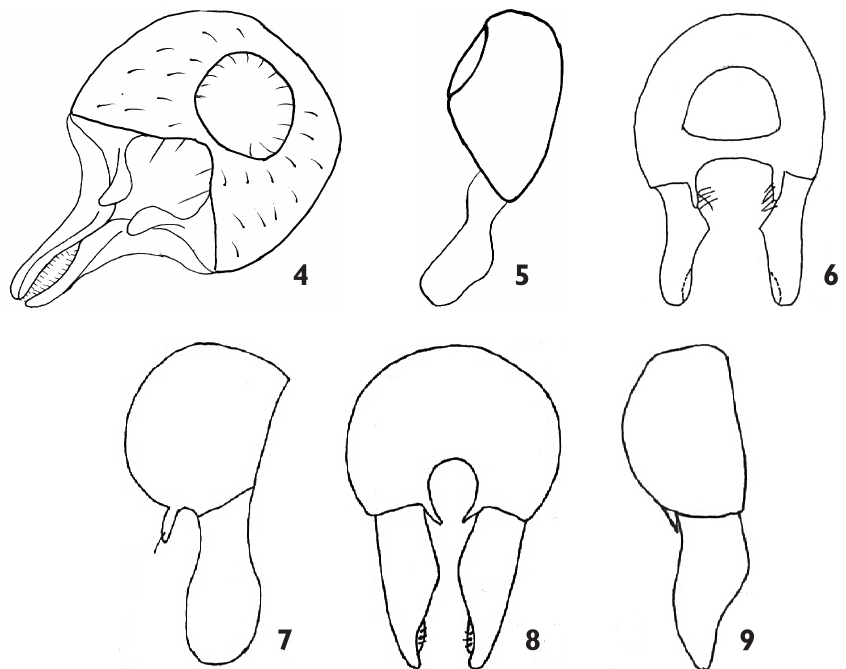
Figure 4–9. 4–5 Dicraeus civeleki sp. n. (holotype): 4 epandrium posterior view 5 epandrium lateral view 6–7 Dicraeus beschovski : 6 epandrium posterior view 7 epandrium lateral view (after Nartshuk 2010) 8–9 Dicraeus sabroskyi : 8 epandrium posterior view 9 epandrium lateral view (after Nartshuk 2010).